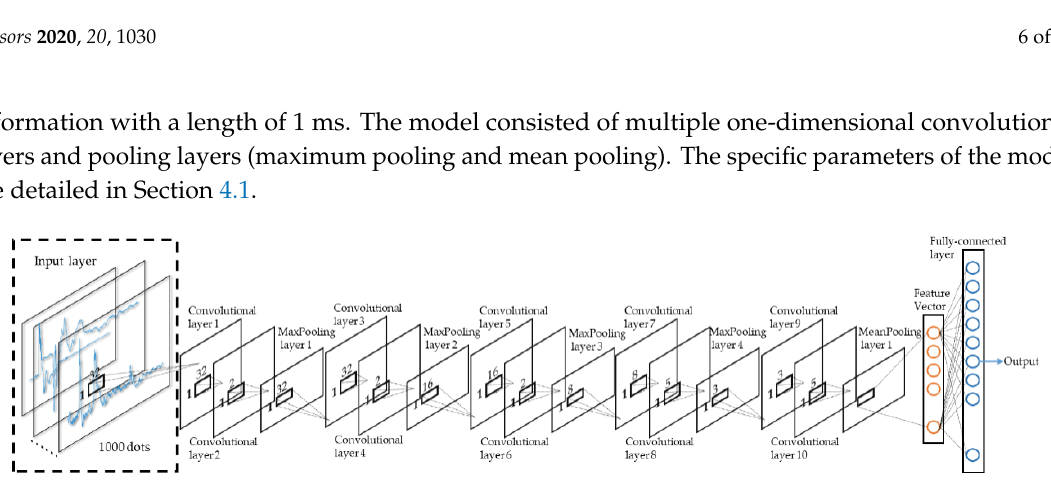
Figure 5. Proposed one-dimensional convolutional neural network (1D-CNN) structure diagram composed of an input layer, ten convolutional layers, five pooling layers, one fully-connected layer, and output.